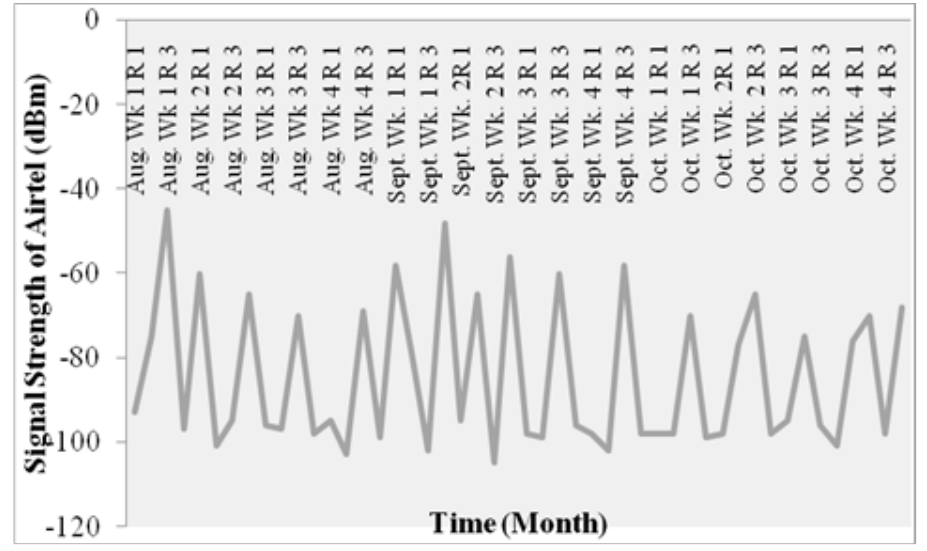
Figure 1: Graphical Representation of Received Signal Strength of Airtel at EACOED,